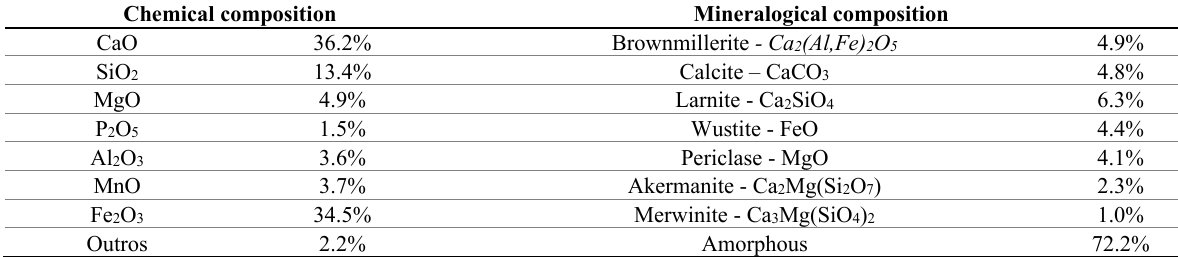
Table 5. Chemical and mineralogical composition of steel slag Chemical composition